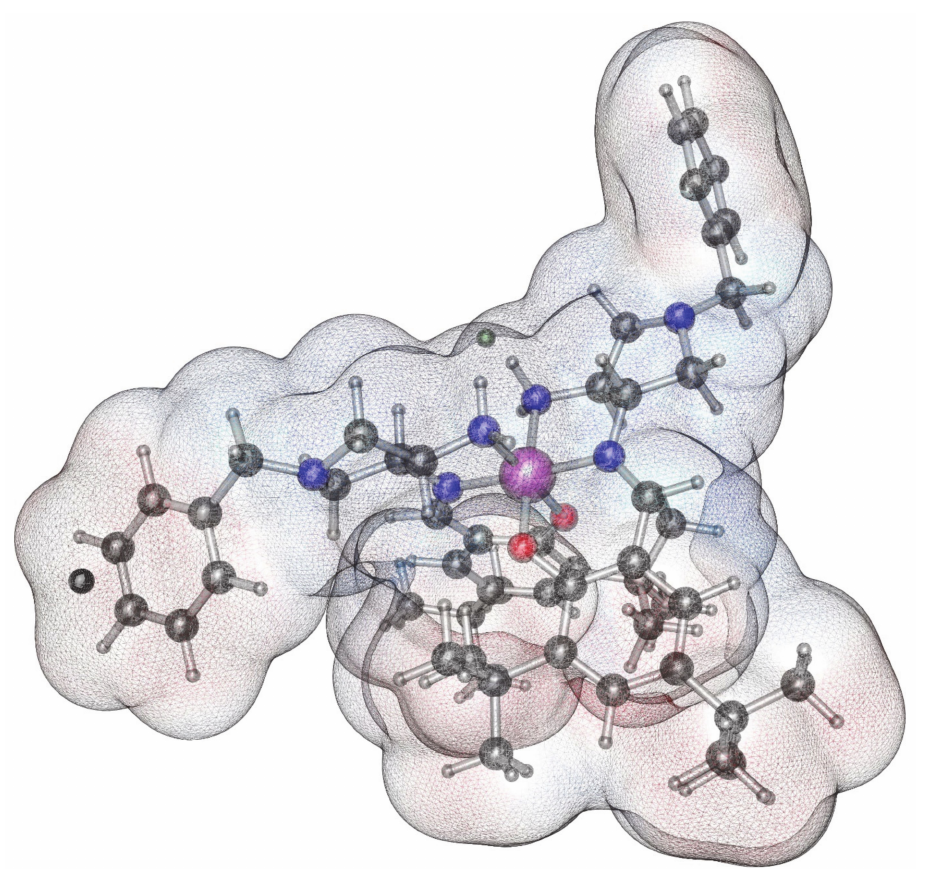
Figure 4. Distribution of the electrostatic potential on the surface of the cation, MEP values range from 20.9 ( red ) to 118.6 kcal/mol ( blue ). Minimum and maximum of MEP are shown with a black and a green